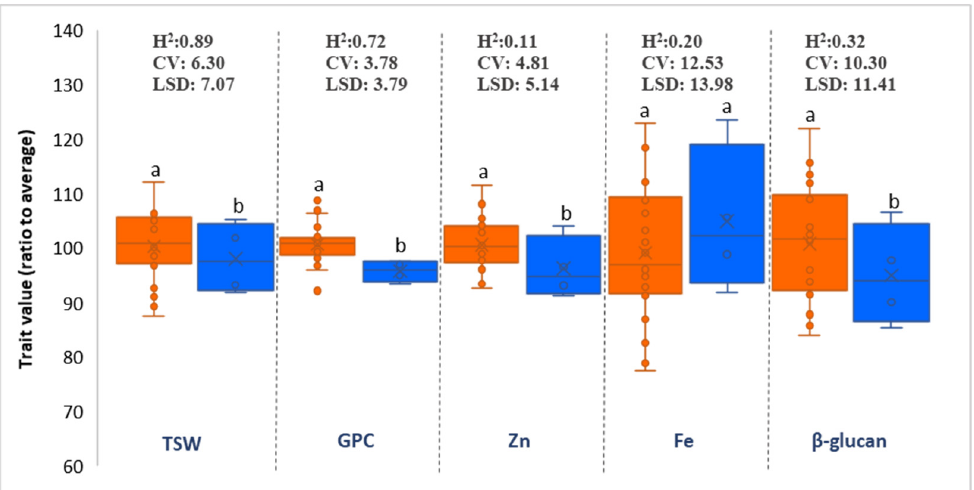
Figure 6. Food transformation characteristics of CWR-derived elite lines of barley (orange) against commercial checks (blue). Values are expressed as ratio-to-average to plot them together. The letters “a” and “b” indicate significant differences at p < 0.05. TSW; 1000-seed weight, GPC; grain protein content, Zn; zinc content, Fe; iron content.